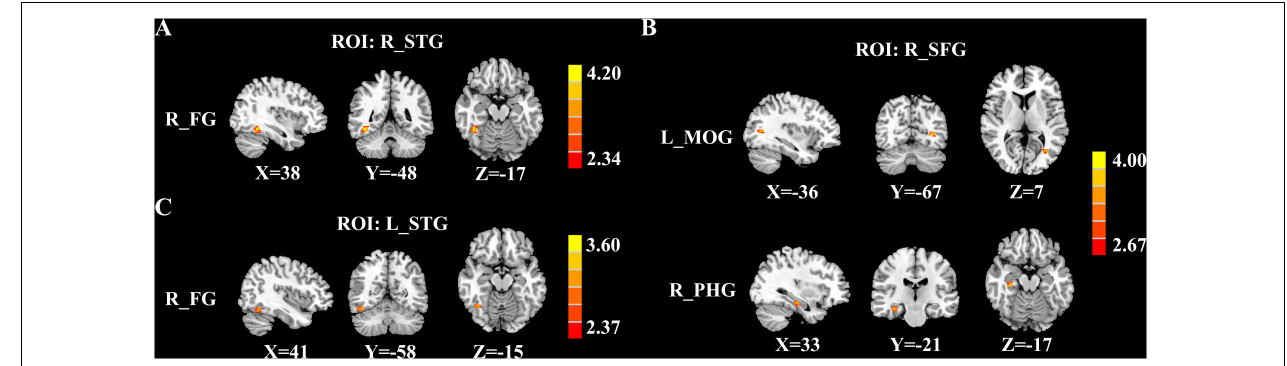
FIGURE 3 | Significant group differences in CBF connectivity among the chronic tinnitus (CT), acute tinnitus (AT), and healthy controls (HC). (A) Compared with AT patients, CT patients exhibited increased CBF connectivity between the right superior temporal gyrus (STG) and the right fusiform gyrus (FG). (B) Compared with AT patients, CT patients also showed increased CBF connectivity between the right superior frontal gyrus (SFG) and the left middle occipital gyrus (MOG) as well as the right parahippocampal gyrus (PHG). (C) Compared with HC, the CT patients showed increased CBF connectivity between the left STG and the right FG. Significant thresholds were corrected using FDR criterion and set at p < 0.01.